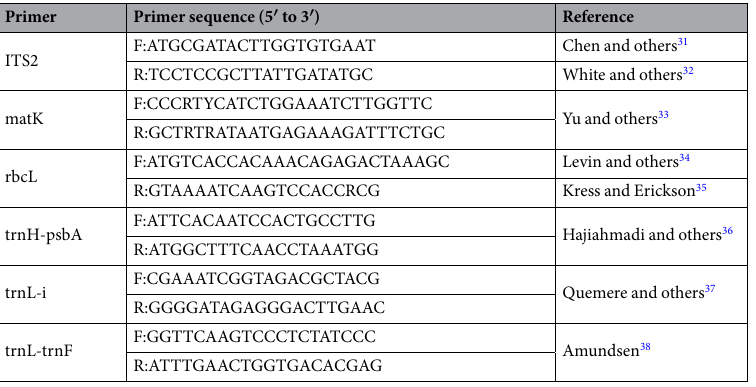
Table 3. Primers for PCR